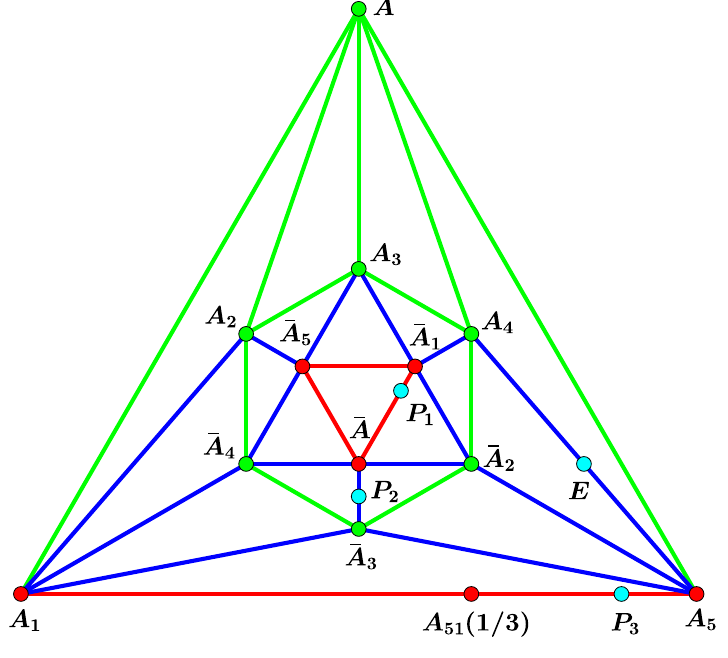
Figure 6. Blue edges joined to hexagon A 2 A 3 A 4 ¯ A 2 ¯ A 3 ¯ A 4